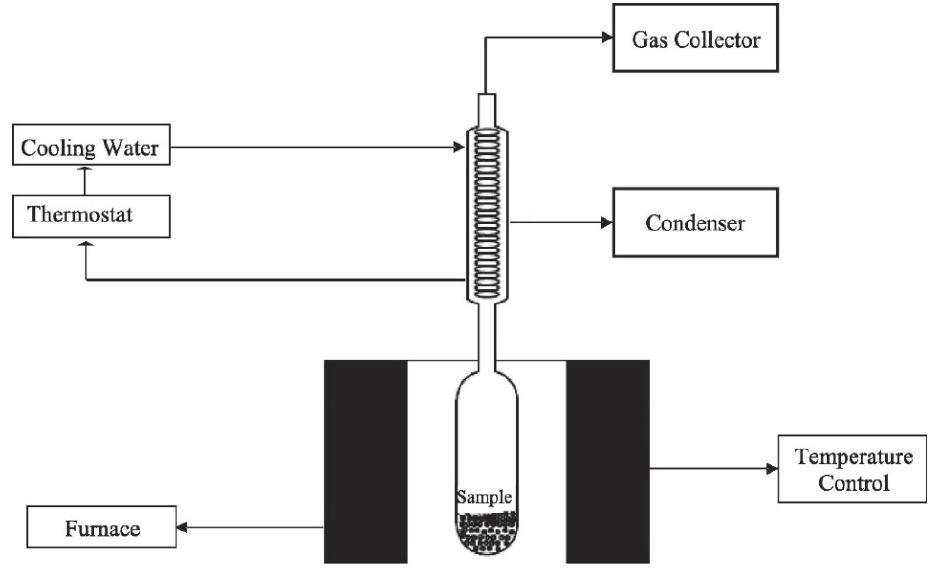
Figure 6. Reactor/separator set-up scheme, reproduced with permission [157.